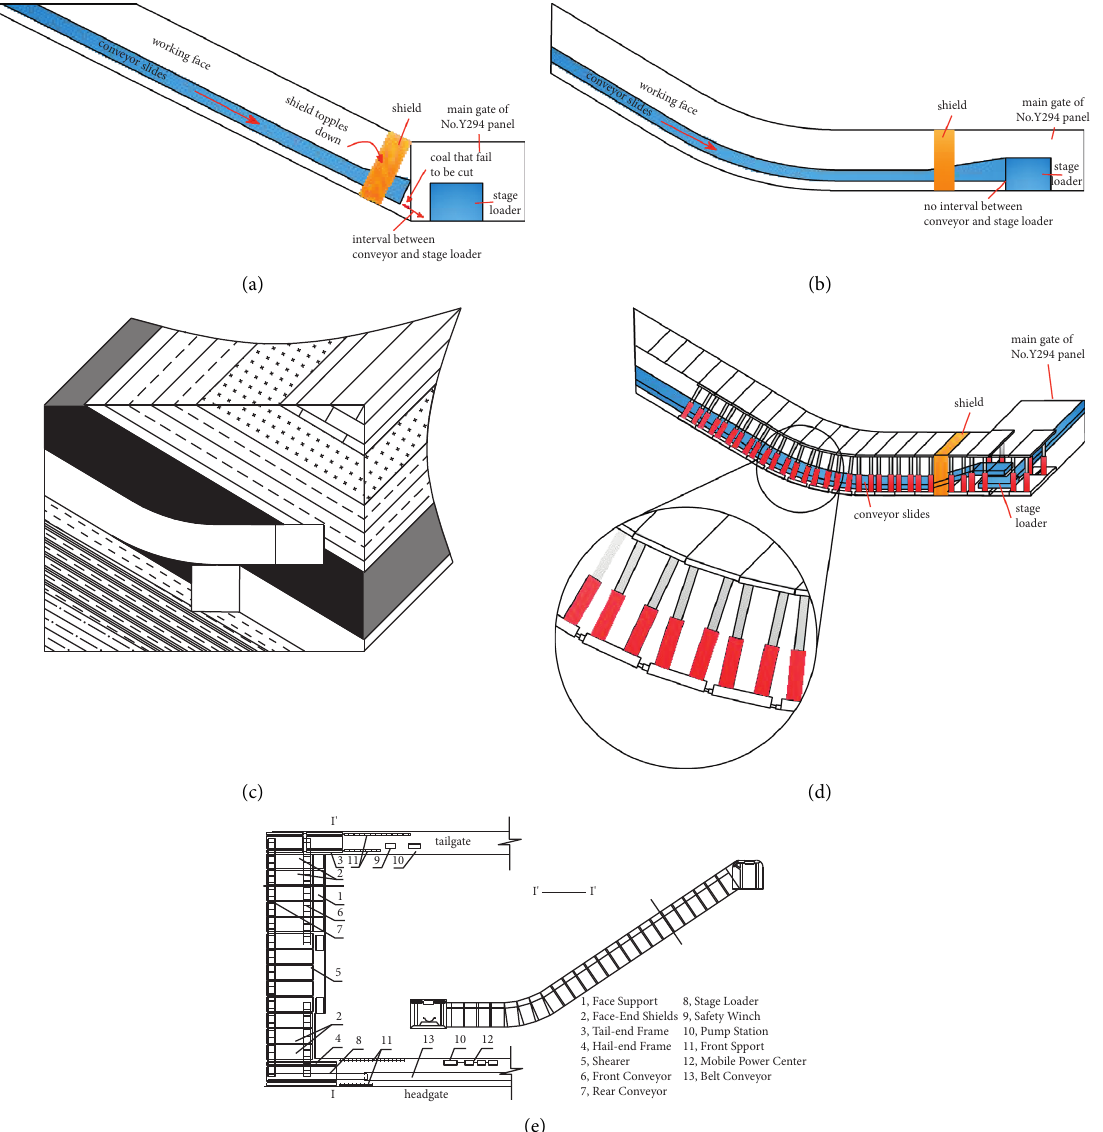
Figure 15: Inclined coal seam: (a) CLL; (b) SLL layout; (c) face overlapping; (d) shields layout and transition; (e) SLL in inclined coal seam in Wangjiashan coal mine [30,